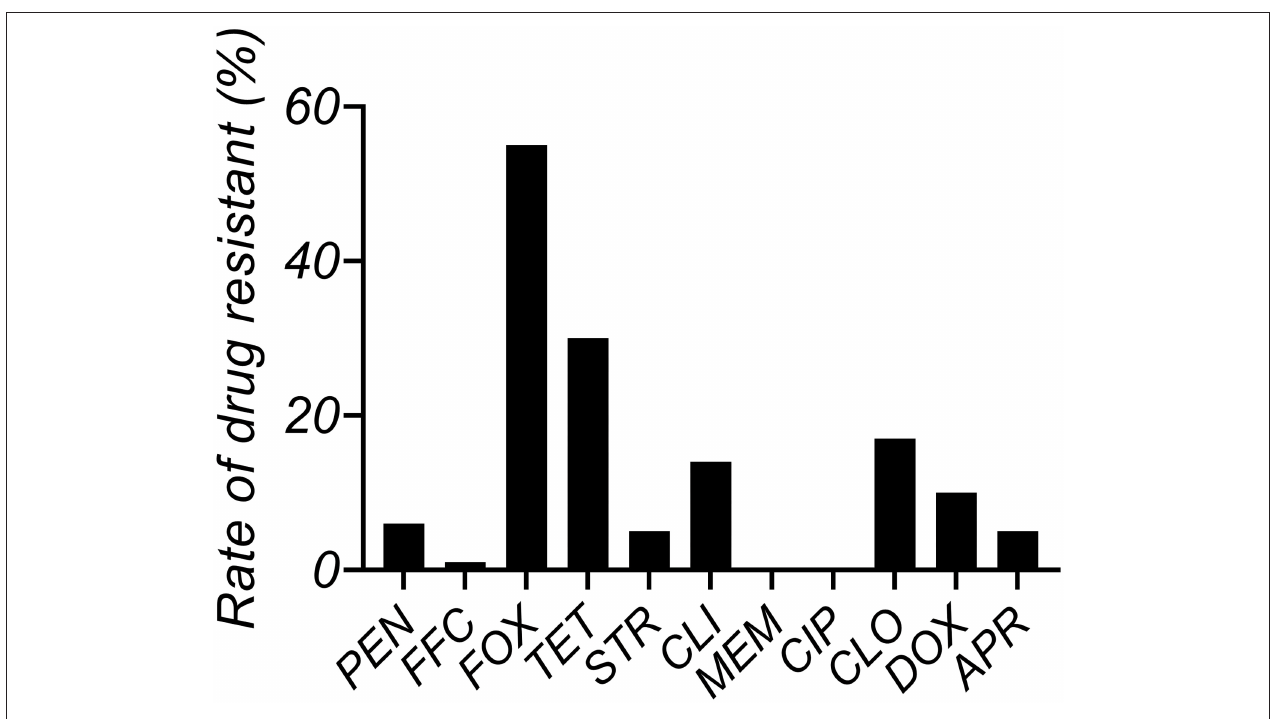
FIGURE 1 | In vitro susceptibility assays of 63 Staphylococcus aureus isolates used in this study.